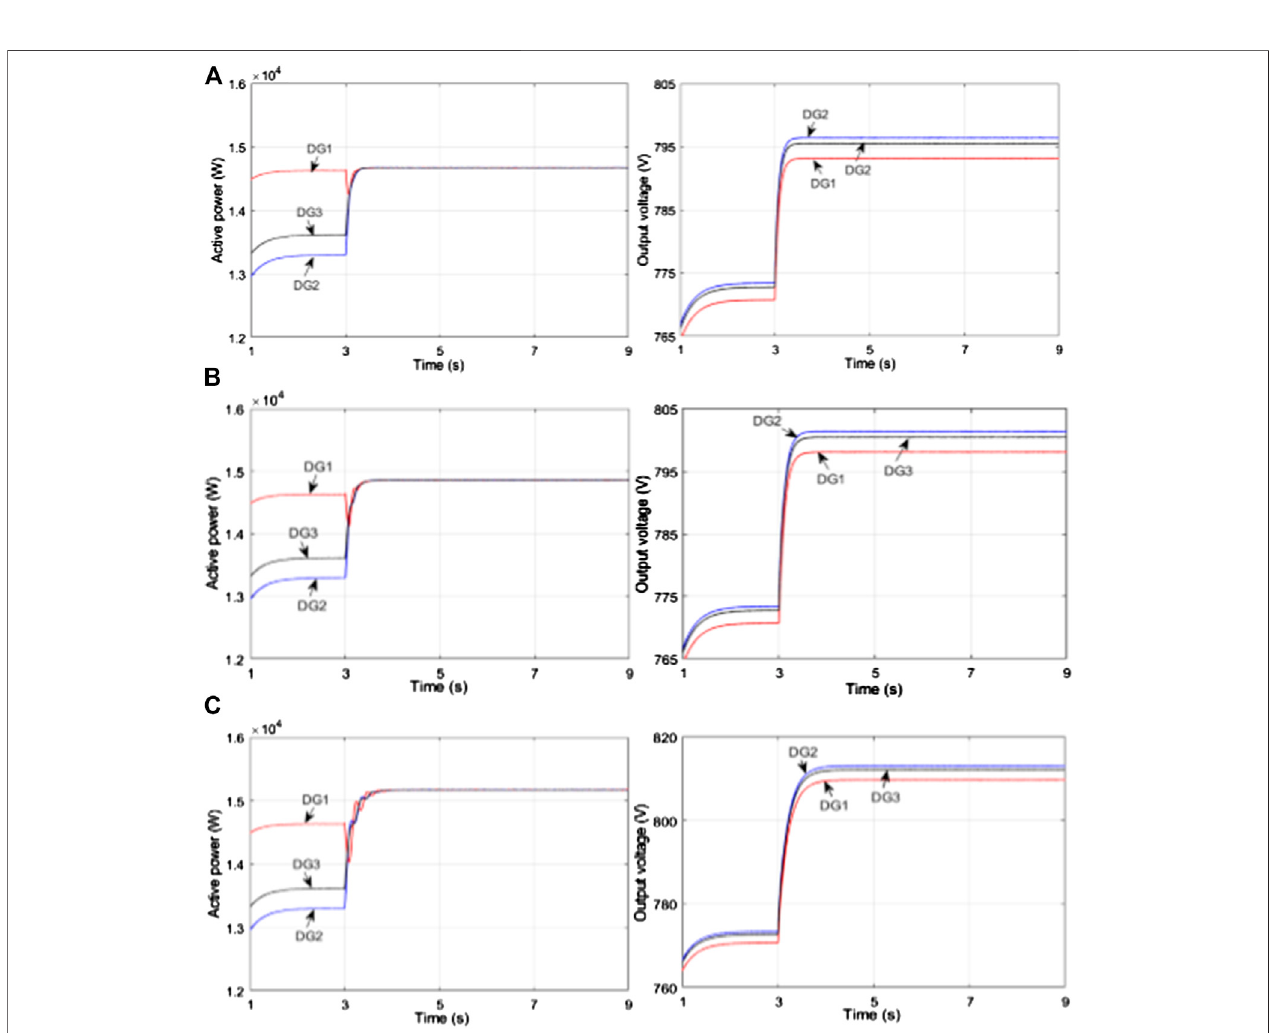
Frontiers in Energy Research |